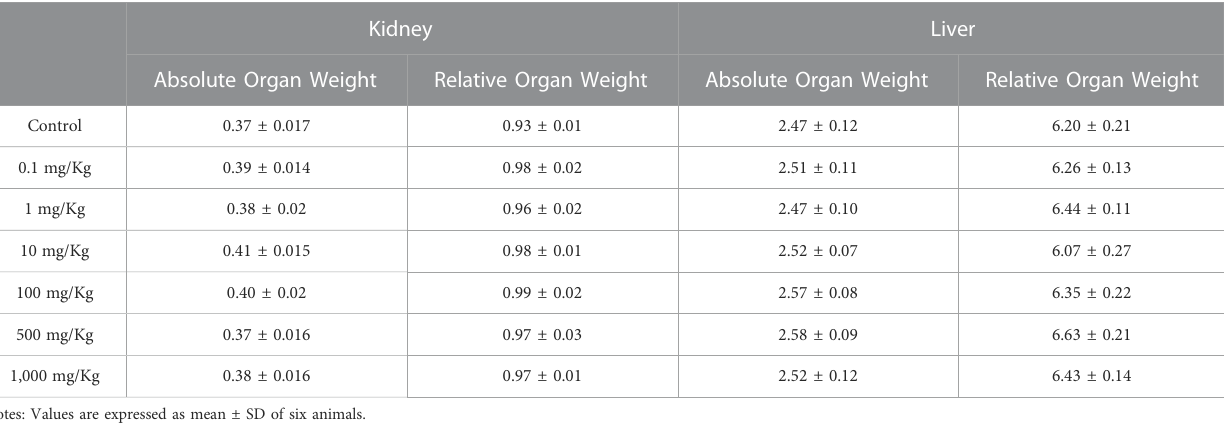
TABLE 8 Organ weight of mice during subacute toxicity.